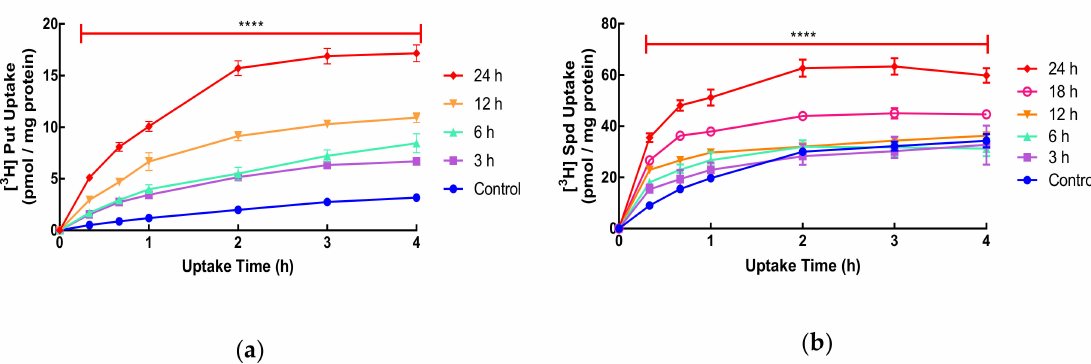
Figure 1. Uptake of putrescine (a) and spermidine (b) by SW480 cells. Cells were seeded at 2.4 × 10 4 cell / cm 2 on 24-well plates and grown for 48 h. Cells were pre-treated with DFMO (5 mM) for varying lengths of time (0–24 h). To measure uptake after exposure to DFMO, cells were incubated with radiolabelled polyamine at each DFMO exposure time for up to 4 h. The final concentration of radioactivity was 5.55 kBq / well (2.4 nM for putrescine or 5.6 nM for spermidine). Uptake was measured by liquid scintillation spectrometry. Values are mean ± SEM when n ≥ 3 or range when n < 3. Putrescine: (control and 24 h n = 6; 6 and 12 h n = 2; 3 h n = 1) with four replicates per experiment. Spermidine: (control and 24 h n = 3; 3 and 6 h n = 2; 12 and 18 h n = 1) with two replicates per experiment. For 24 h, P : **** < 0.0001, compared to the respective control.